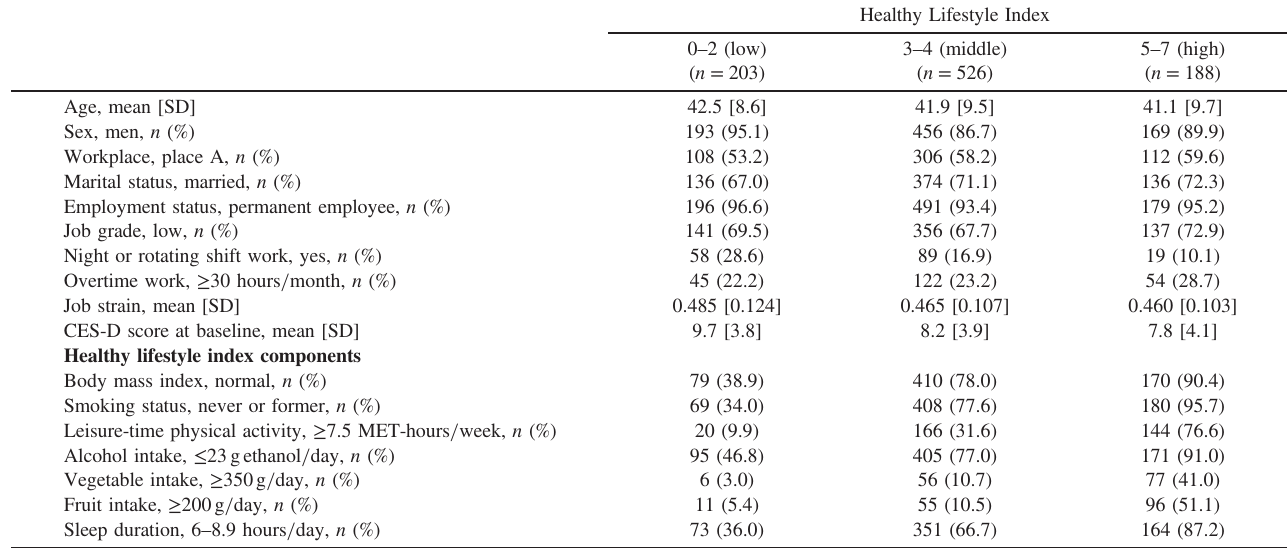
Table 2. Baseline characteristics of participants in the Furukawa and Nutrition Study (2012 – 2013) according to the Healthy Lifestyle Index